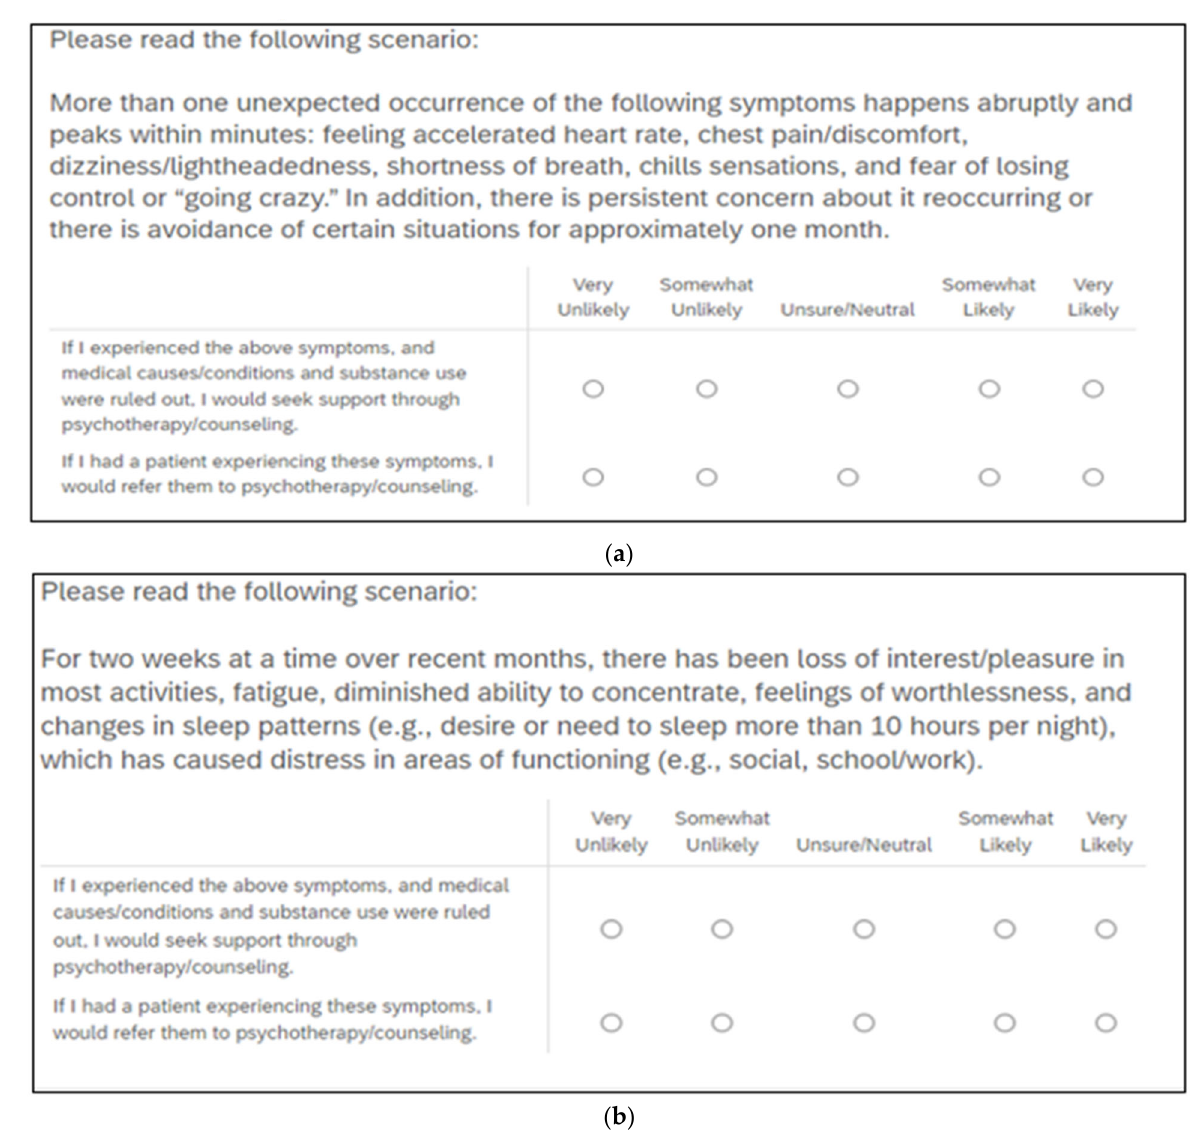
Figure 1. a : Panic Disorder. b : Major Depressive Disorder. Figure 1. ( a ): Panic Disorder. ( b ): Major Depressive